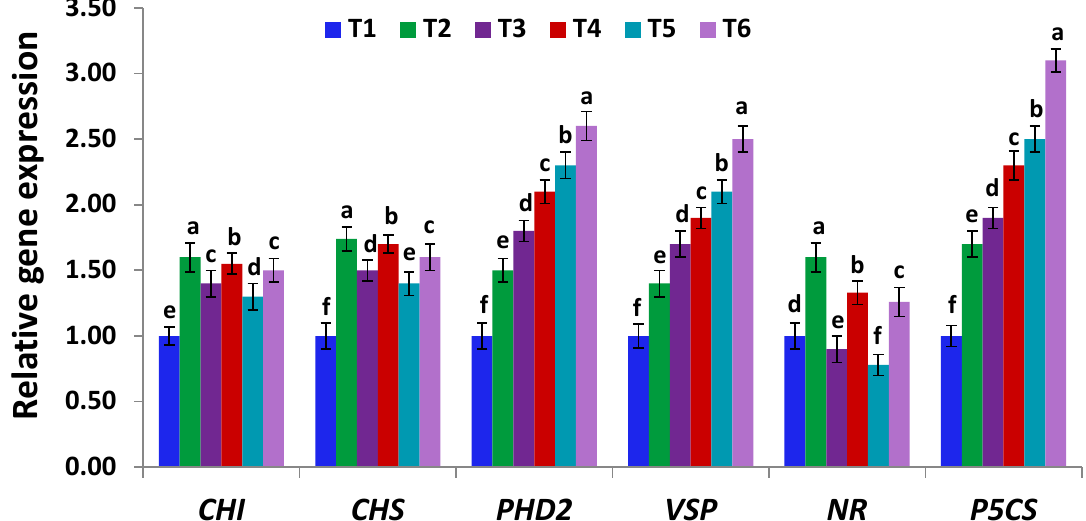
Figure 4. Expression levels of CHI, CHS, PHD2, VSP, NR and P5CS genes in leaves of un-inoculated and inoculated soybean plants with Serratia marcescens BM1 under Cd stress. Data are means ± SE ( n = 4). Different letters (a–f) above the chart columns indicate significant differences between treatments ( p ≤ 0.05). T1, control with no Cd and BM1 treatment; T2, plant treated with Serratia marcescens BM1;